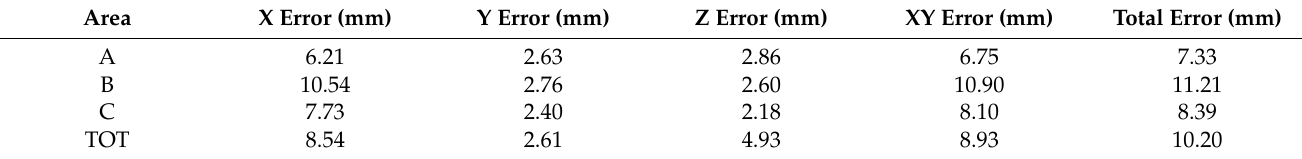
Table 2. Average camera location error of areas surveyed. X—longitude, Y—latitude, Z—altitude (see camera locations and z errors in Figures